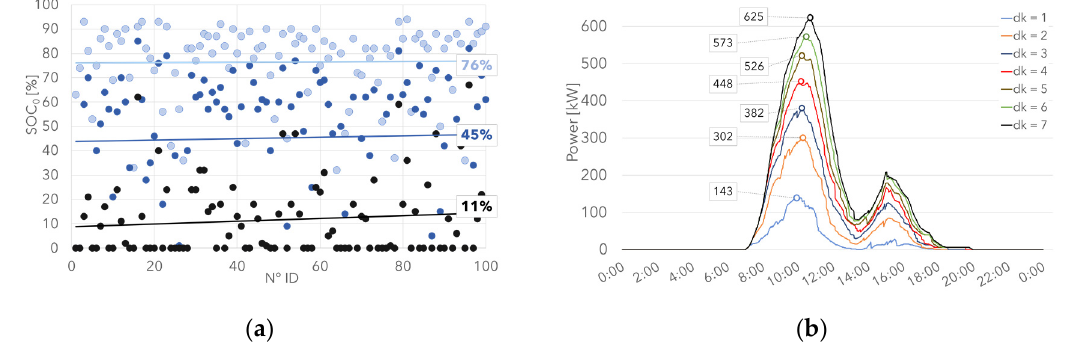
Figure 9. Results of the forecasting method: ( a ) the input value of SOC 0 referred to d k = [1; 3; 7] for each vehicle and their average value; ( b ) the total EVs’ power flows referred to d k = [1 ÷ 7] and their peak value.